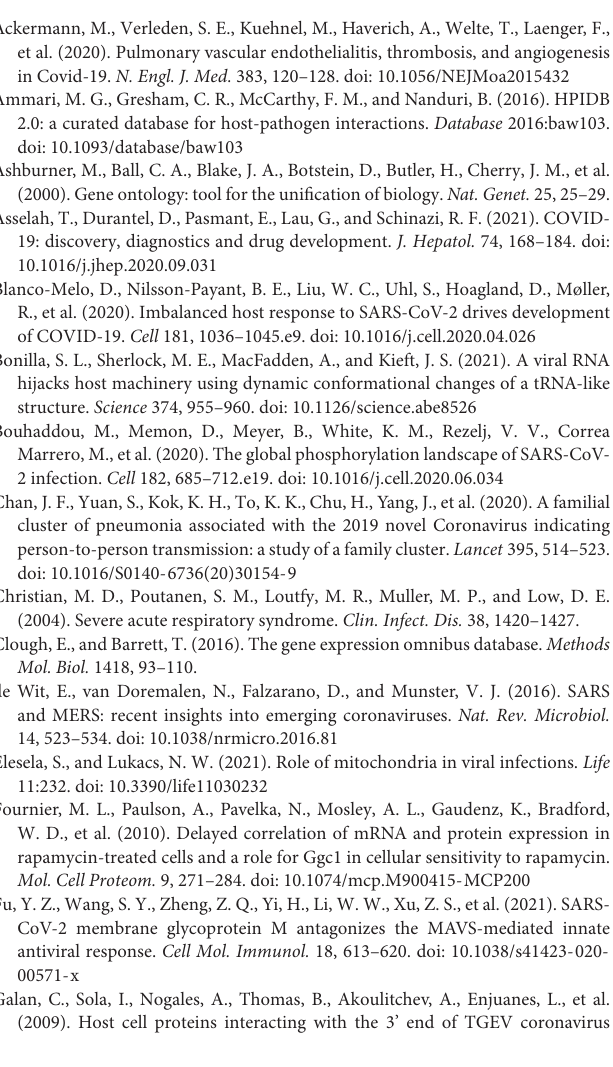
Supplementary Figure 2 | Z scores of cytoplasmic (cyto) and mitochondrial translation- and ribosome-related genes in Vero-E6 cells challenged with different coronaviruses (CoVs). Transcriptional expressions of translation- and ribosome-related genes (blue), translation-related genes (green), and ribosome-related genes (red) based on a genome-wide CRISPR screening were clustered by their mean Z scores with red representing Z > 0 while blue representing Z < 0. * p < 0.05; ** p < 0.01 (vs. mock-infected cells). Supplementary Figure 3 | Transcriptional profiles of cytoplasmic (cyto) and mitochondrial translation- and ribosome-related DEGs in patient-derived samples and cell lines infected with SARS-CoV-2. Heatmaps of translation- and ribosome-related DEGs (with the cyto DEGs on the left and the mitochondrial DEGs on the right) in BALF, post-mortem lung tissues from coronavirus disease 2019 (COVID-19) patients, as well as in NHBE and A549-ACE2 cells infected with SARS-CoV-2. The fold change in gene expression is indicated by color intensity, with red representing the upregulated DEGs and blue representing the downregulated DEGs. The DEGs include translation- and ribosome-related genes (blue), translation-related genes (green), and ribosome-related genes (red). Supplementary Figure 4 | Cytoplasmic (cyto) translation- and ribosome-related DEPs and the total protein levels of certain aminoacyl-tRNA synthetases (aaRSs).